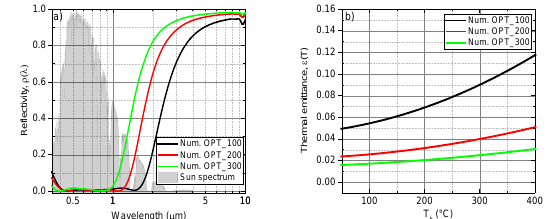
Fig. 1 : Optical simulations. (a) Spectral reflectivity of three coatings optimized for a target temperature of 100 °C, 200 °C, and 300 °C (black, red, and green curve, respectively). Normalized Sun spectrum, grey filled area. (b) Temperature-dependent thermal emittance of three coatings optimized for a target temperature of 100 °C, 200 °C, and 300 °C (black, red, and green curves, respectively).